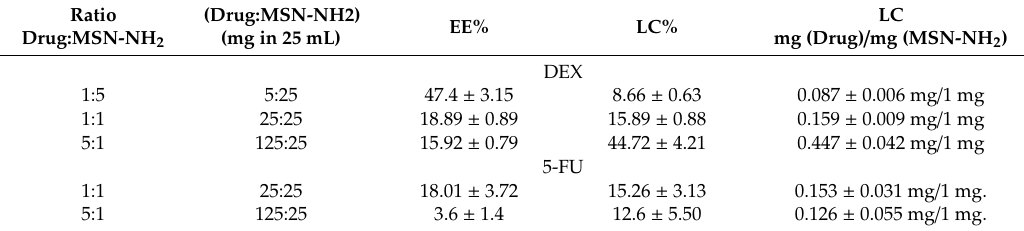
Table 1. EE%, LC%, and LC in mg mg (Drug) / mg (MSN-NH 2 ) of DEX MSN-NH 2 and 5-FU MSN-NH 2 using di ff erent drug: MSN-NH 2